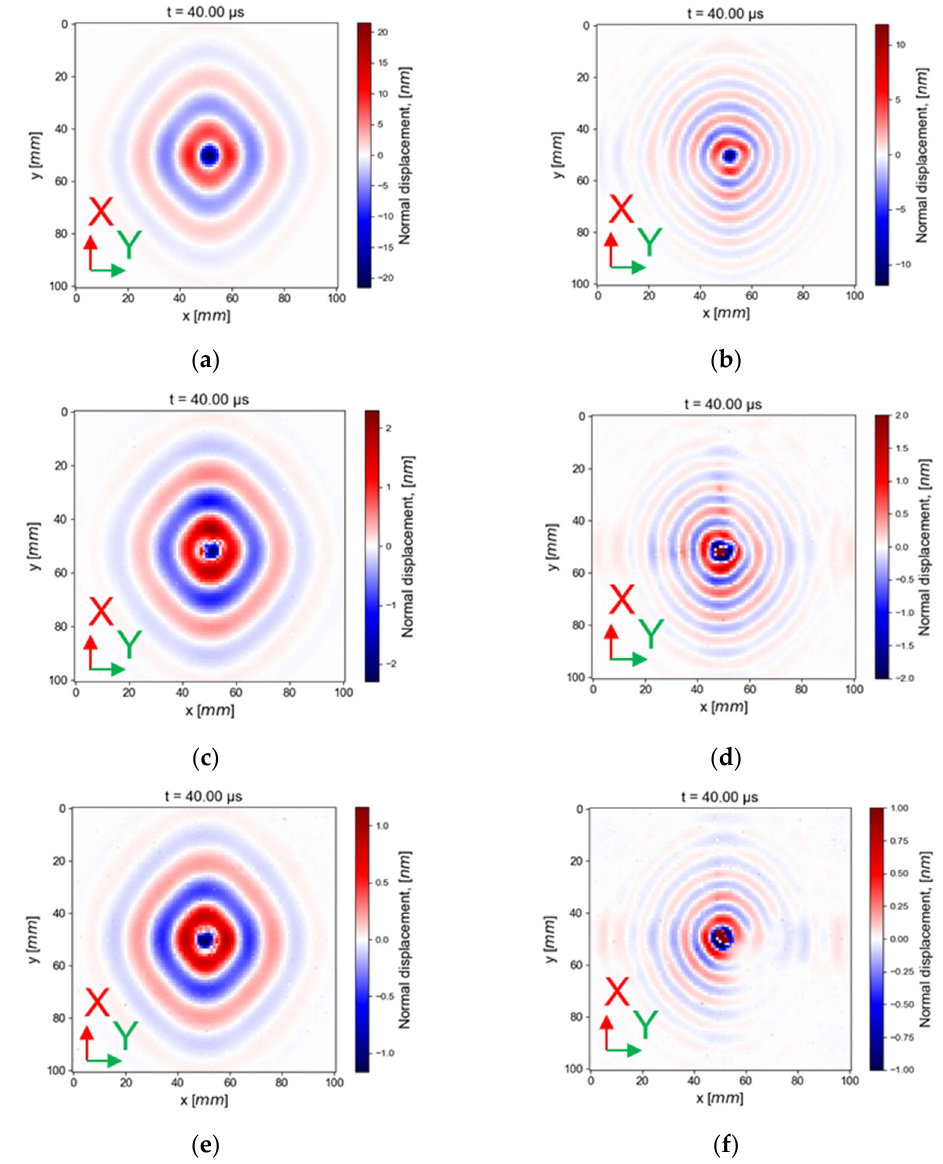
Figure 11. Wave generation, ( a ) Surface-mounted generation at 50 kHz and ( b ) at 150 kHz, ( c ) an embedded PZT in cut-out at 50 kHz and ( d ) at 150 kHz, ( e ) an embedded PZT between two plies at 50 kHz and ( f ) at 150 kHz at 40 µs.